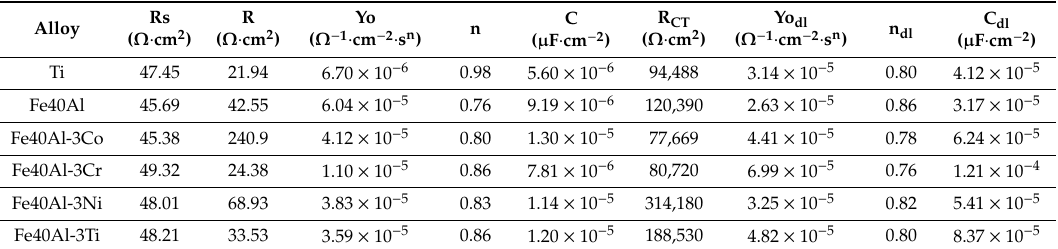
Table 4. Electrochemical parameters of the electrochemical impedance spectroscopy (EIS) spectra after 24 h of immersion in artificial